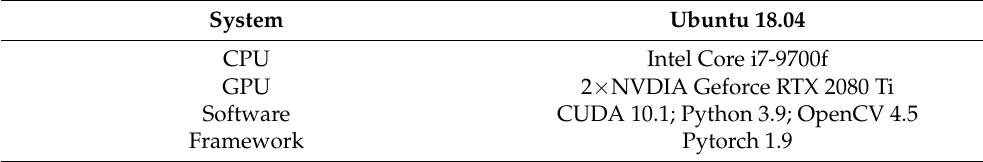
Table 3. The experimental environment.